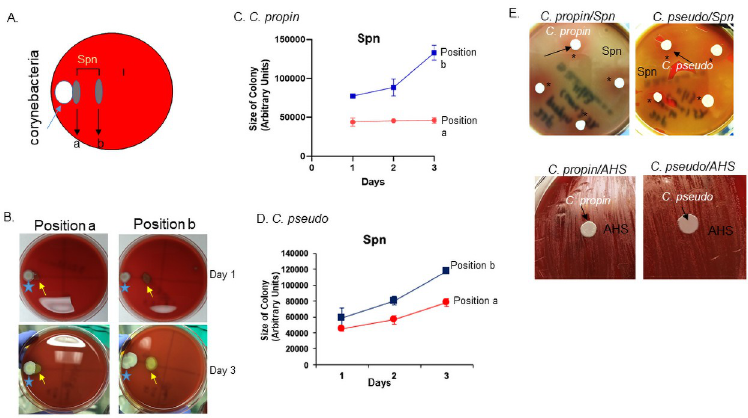
Fig 5. Growth inhibition of Corynebacterium by Spn. A) Schematic representation of co-culture experiment for Corynebacterium spp. and Spn. Spn22F was inoculated right next to a Corynebacterium colony (position a) or with some distance (position b). B) Representative images of Corynebacterium spp. co-cultured with Spn22F at position a or b (as shown in A) on day 1 and day 3. C, D) Measurement of size changes in Spn colonies placed at positions a and b next to C . propinquum (C) or next to C . pseudodiphtheriticum (D) over 3 days. E) Images of culturing C . propinquum (left) or C . pseudodiphtheriticum (right) on top of a lawn of Spn22F (top panels) or AHS (bottom panels).